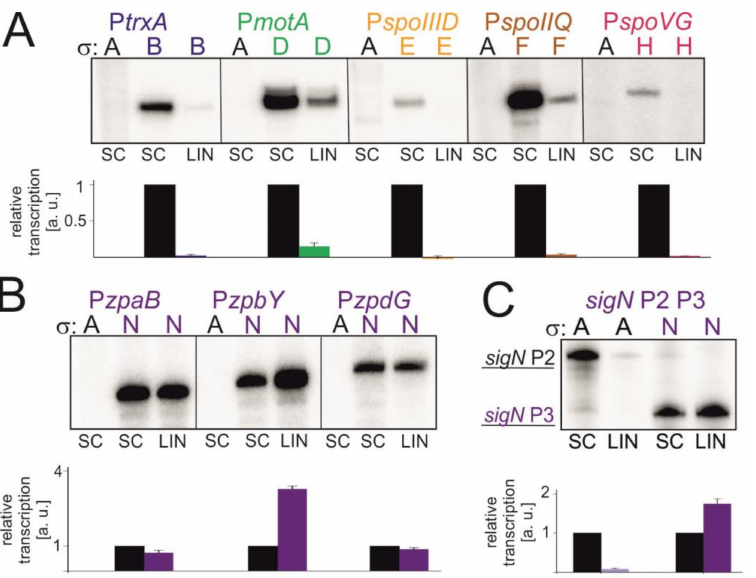
Figure 6. Transcription in vitro with alternative σ factors on different DNA templates. Representative primary data are shown (radioactively labelled transcripts resolved by polyacrylamide electrophore- sis). SC stands for supercoiled promoter DNA, LIN for linear DNA. Letters above the gels indicate the sigma factor used—A for σ A , B for σ B etc. Each sigma factor is depicted with different color ( σ A , black; σ B , dark blue; σ D , green; σ E , yellow; σ F , brown; σ H , red and σ N , purple). For each promoter three independent experiments were performed. Transcription from SC was set as 1 for each pro- moter. Quantitation of results is shown in graphs below the respective primary data. The graphs show averages ± SD. The reactions with σ A on all promoter fragments were used to show that the observed transcription was due to the addition of the specific σ factors and not due to (theoretical) contamination of the core with σ A . ( A ) Transcription in vitro from selected σ B , σ D , σ E , σ F and σ H -dependent promoters. ( B ) Transcription in vitro from σ N -dependent promoters. ( C )